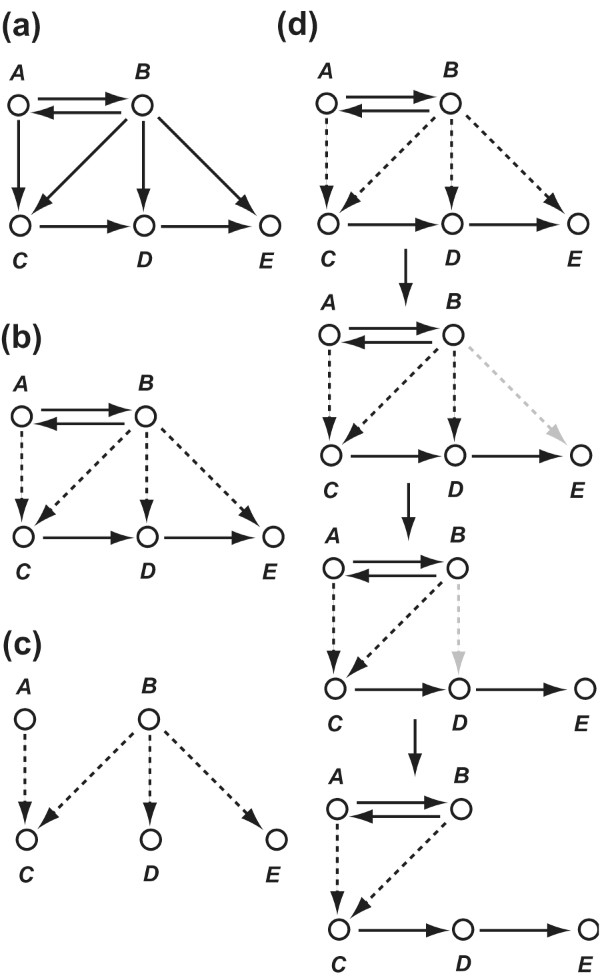
Example of uncovered edges in peripheral and main components. (a) Initially deduced edges (Eide). (b) Essential edges (Ees). Non-essential edges are dotted. (c) Uncovered edges (Eucv). Because all non-essential edges cannot be covered by essential edges, the non-essential edges are called uncovered edges (Eucv). (d) Uncovered edges in peripheral components (gray-dotted). (B, D) and (B, E) are uncovered edges in peripheral components because (B, E) does not explain any other edges in Eucv with an edge in Eide, and (B, D) does not explain any other edges in Eucv except (B, E) with an edge in Eide. (A, C) and (B, C) are uncovered edges in main components. If edges in a MEGN cover (A, C) and (B, C), the edges also cover (B, D) and (B, E). (B, D) and (B, E) cover no edges except themselves. Thus, (B, D) and (B, E) are not included in the MEGNs.